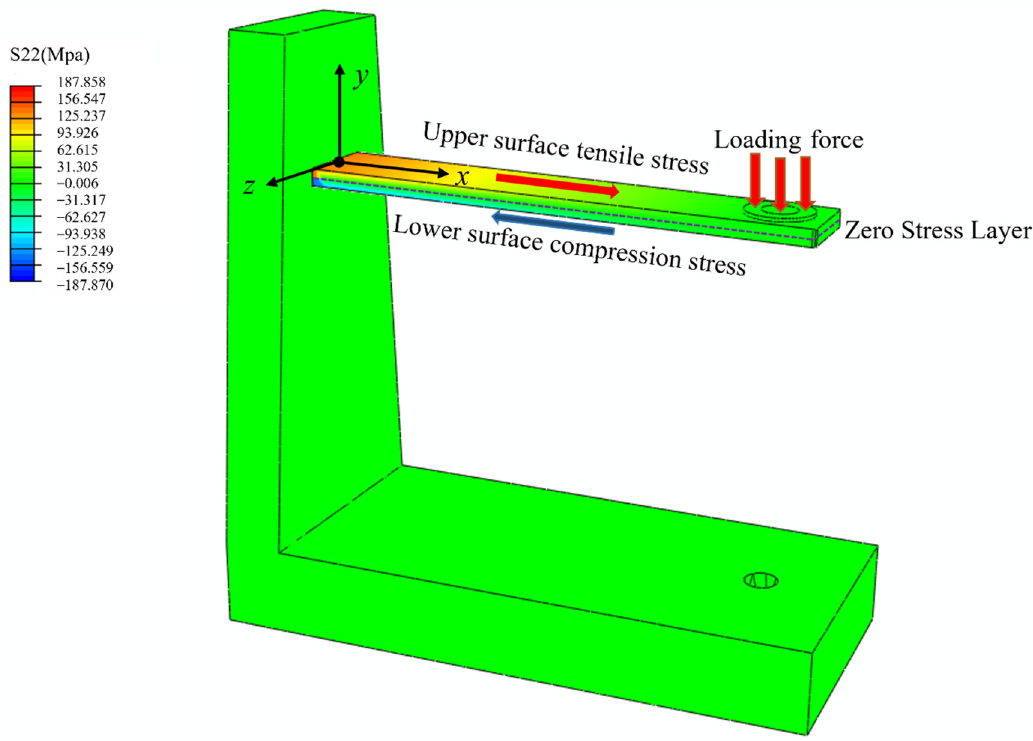
Figure 6. Horizontal normal stress distribution diagram of the cantilever beam.